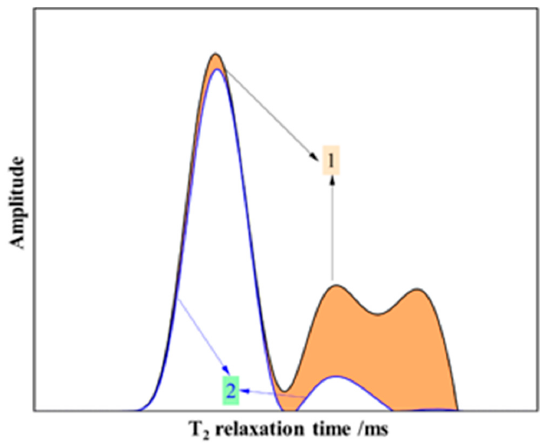
Figure 1. NMR T 2 spectrum curve of before and after the experiment. 1 denotes the oil-bearing T 2 spectrum curves before the experiment, and 2 denotes the oil-bearing T 2 spectrum curves after the experiment.